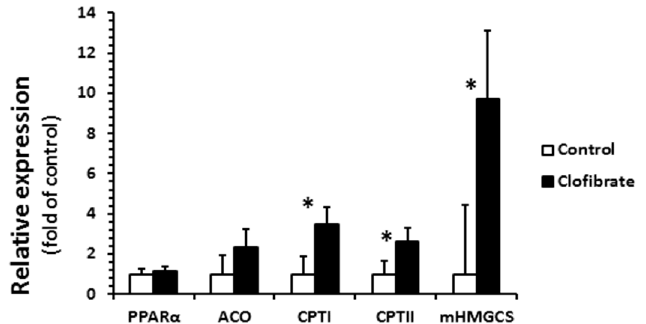
Figure 5. Renal mRNA abundance in pigs with and without oral clofibrate. Values are least square means ± SEM ( n = 5). PPAR α : peroxisome proliferator-activated receptor α ; ACO: acyl-CoA oxidase; CPT I and CPT II: carnitine palmitoyltransferase I and II; mHMGCS: mitochondrial 3-hydroxy-3-methylglutaryl-coenzyme A synthase. * Significant difference between control and treatment groups ( p < 0.05).